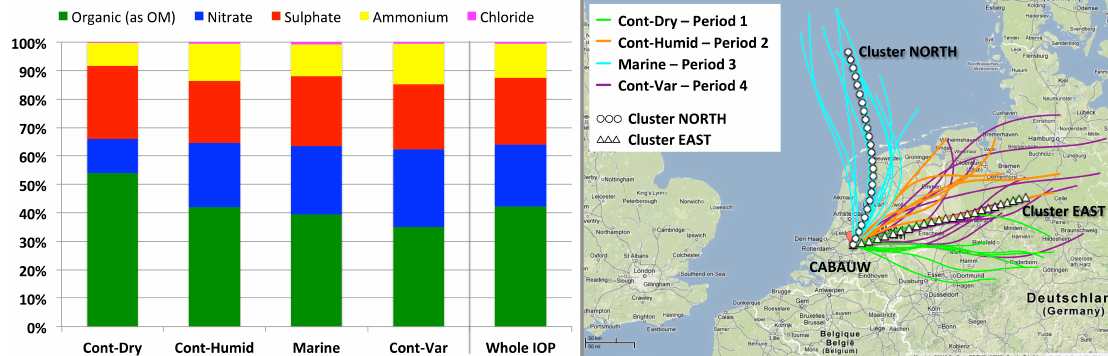
Fig. 1. Average PM 1 -filters’ chemical composition and back-trajectory analysis for the four periods of the campaign. Organics are reported as total organic matter (OM) calculated by the relationship OM=OC PM Published by Copernicus Publications on behalf of the European Geosciences